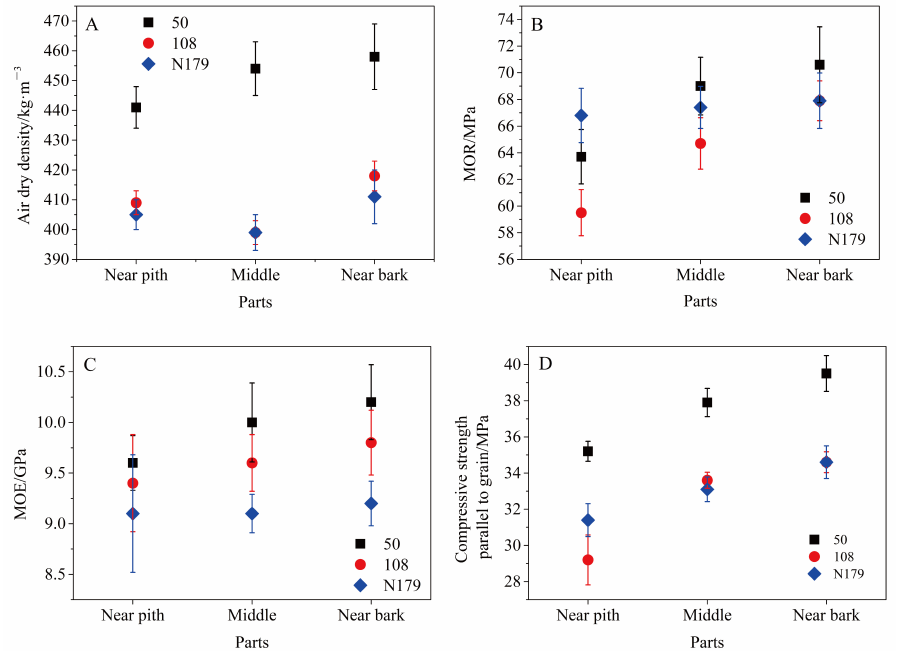
Figure 3. Radial variation of the physical and mechanical properties in three poplar clones. ( A ): air dry density; ( B ): modulus of rupture (MOR); ( C ): modulus of elasticity (MOE); ( D ): compressive strength parallel to